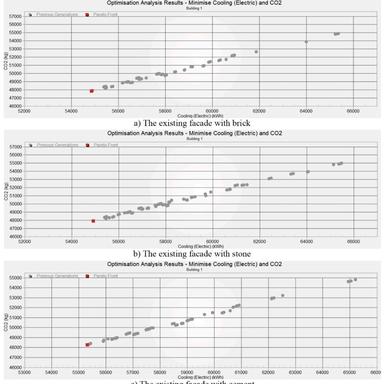
Optimization results for the existing façade with three mentioned coatings: A) brick, B) stone, and C) cement.